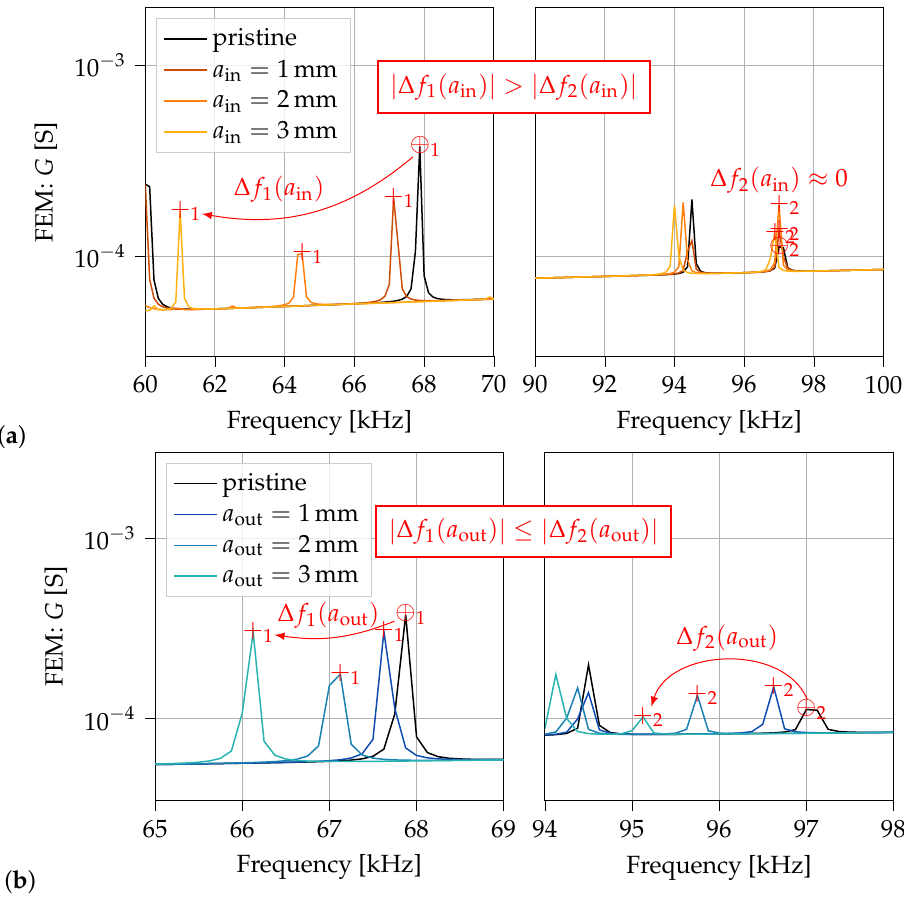
Table 3. It is clearly seen, that in measured and calculated spectra ∆ f 2 0 %, which indicates a crack at β in = 90°. | | ≈